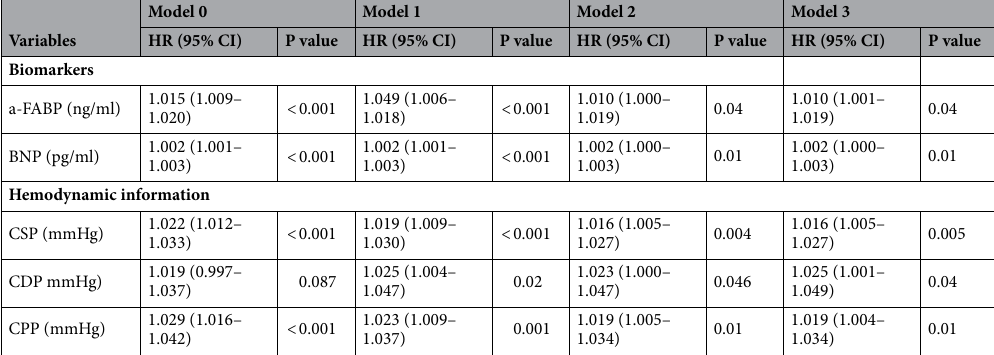
Table 3. Predictors of future HF hospitalizations. Variables with a p values < 0.10 in Model 0 were selected into Model 1–Model 3 for evaluating adjusted effects. Model 0 : Crude effect; Model 1: Adjusted for